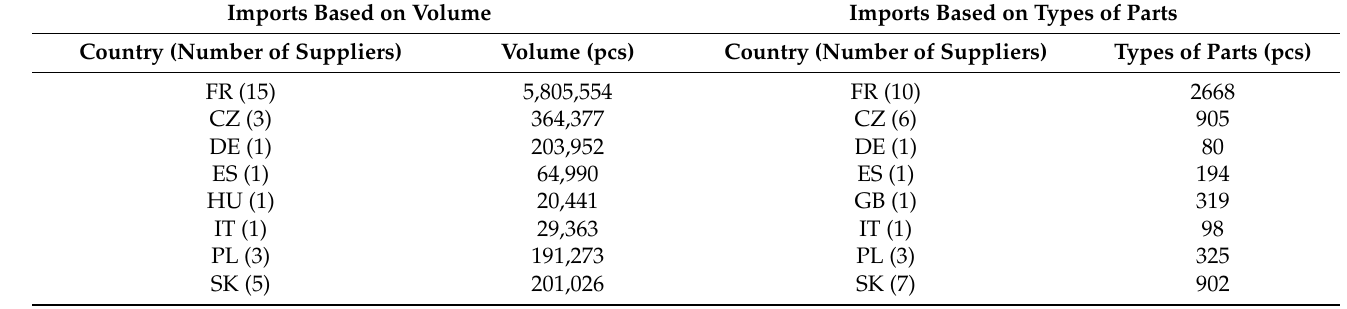
Table 1. The largest suppliers of PSA Group SVK for 2019 in terms of volume of imported units and types of parts.